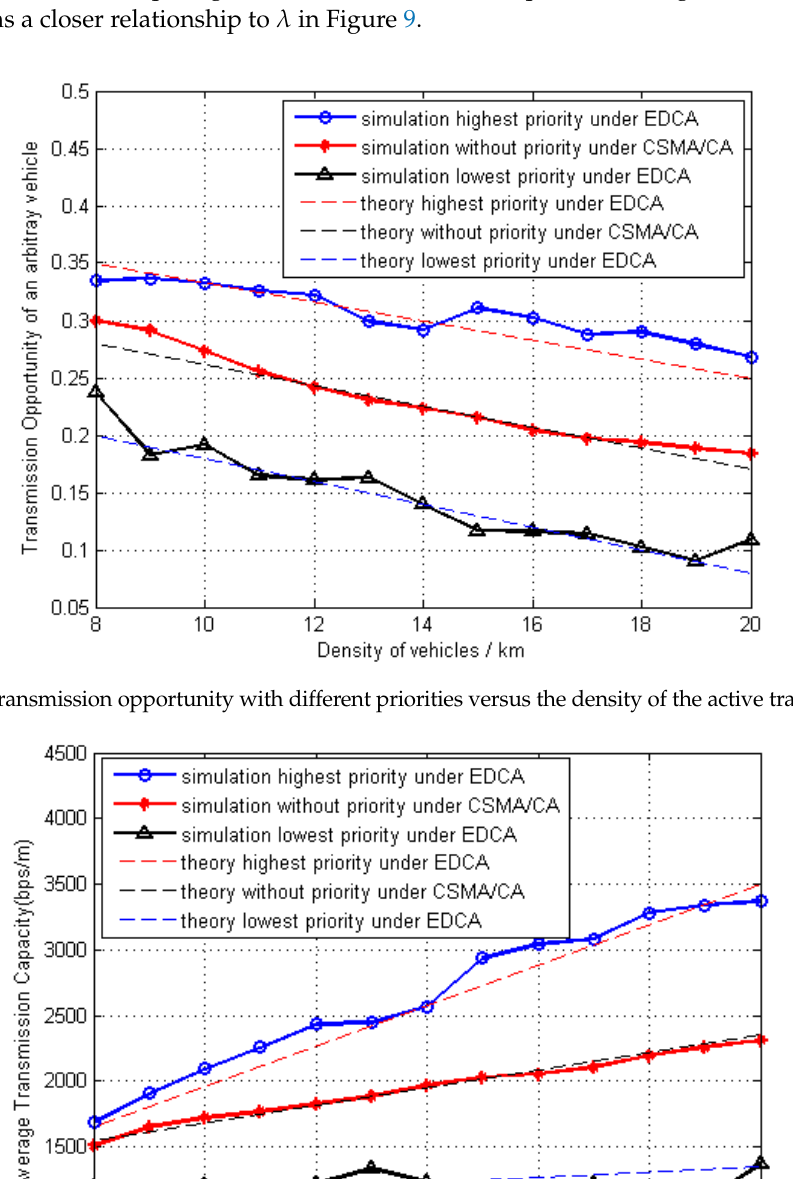
Figure 6. Transmission capacity with different priorities versus the density of the active transmitters.